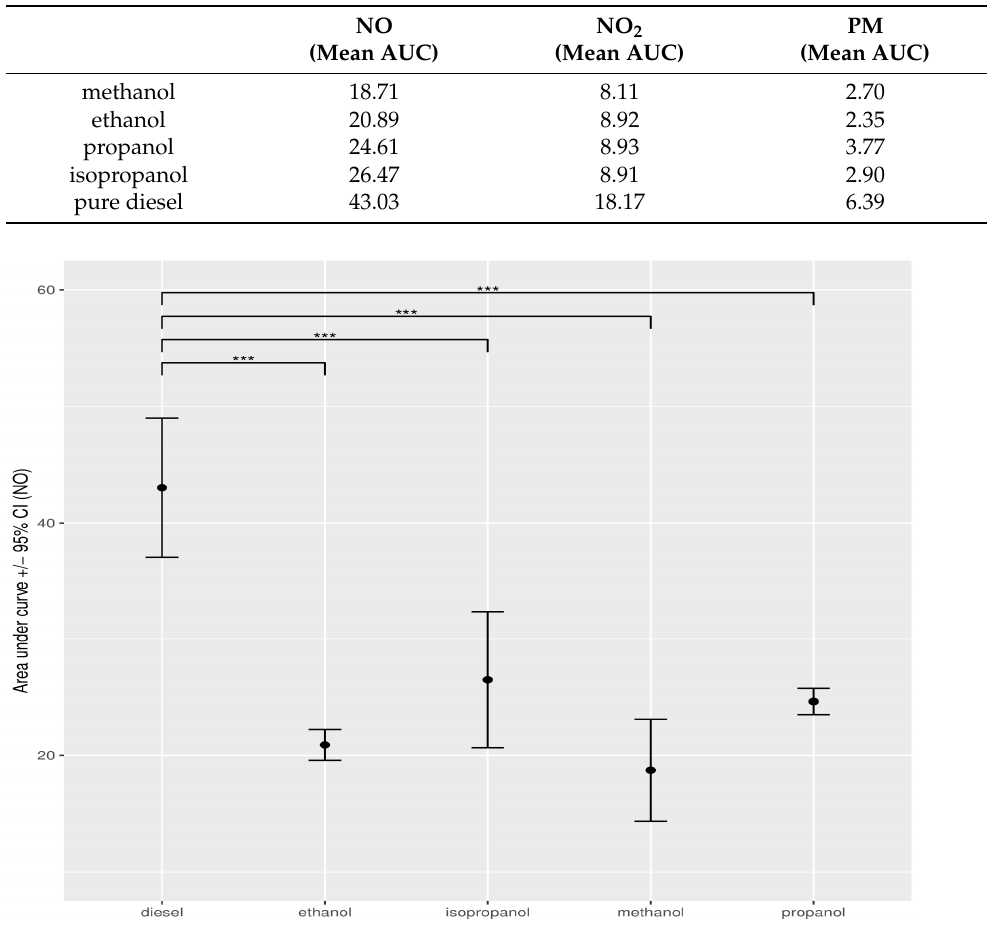
Figure 8. Error analysis bar chart of the concentration of NO, expressed as AUC, measured for the different alcohols between pure and diesel–alcohol mixtures. The dots show the mean AUC value, obtained through bootstrap resampling. Error bars indicate the 95% confidence interval around the mean. Asterisks show the significance of the pairwise comparison of the AUC values *** p < 0.001).